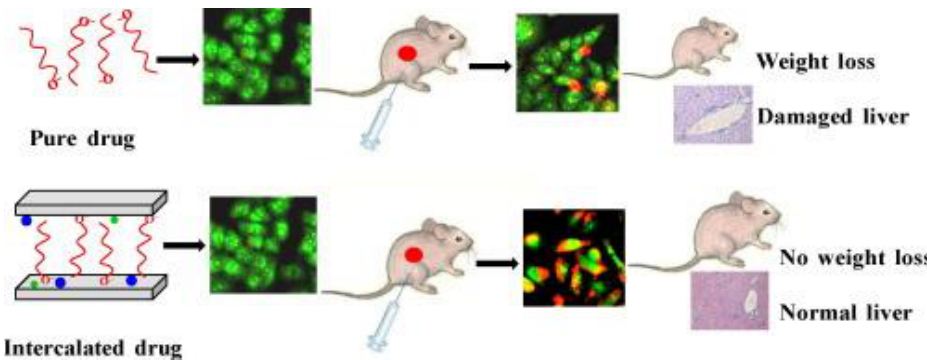
Figure 8. Drug – L DH hybrids as superior anticancer drug delivery systems ‘’Reprinted with permis- Figure 8. Drug–LDH hybrids as superior anticancer drug delivery systems “Reprinted with permis- sion from [152]. 2016, Elsevier B.V.’’ . sion from [152]. 2016, Elsevier